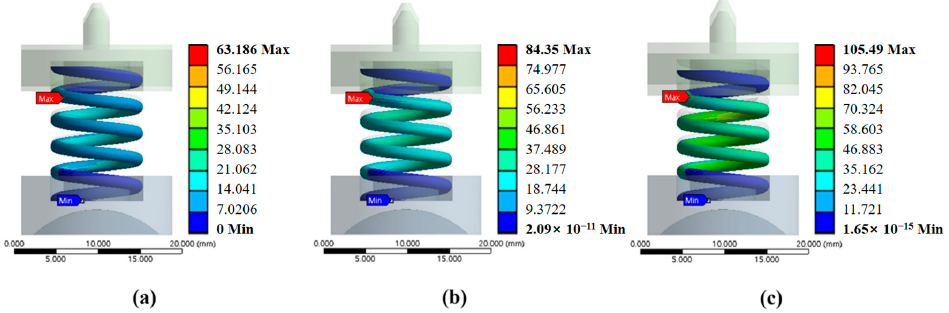
Figure 9. Von-Mises stress distribution of SMA coil springs applied the specific water pressure conditions to the top part of disc protrusion: ( a ) 3 bars; ( b ) 4 bars; ( c ) 5 bars.